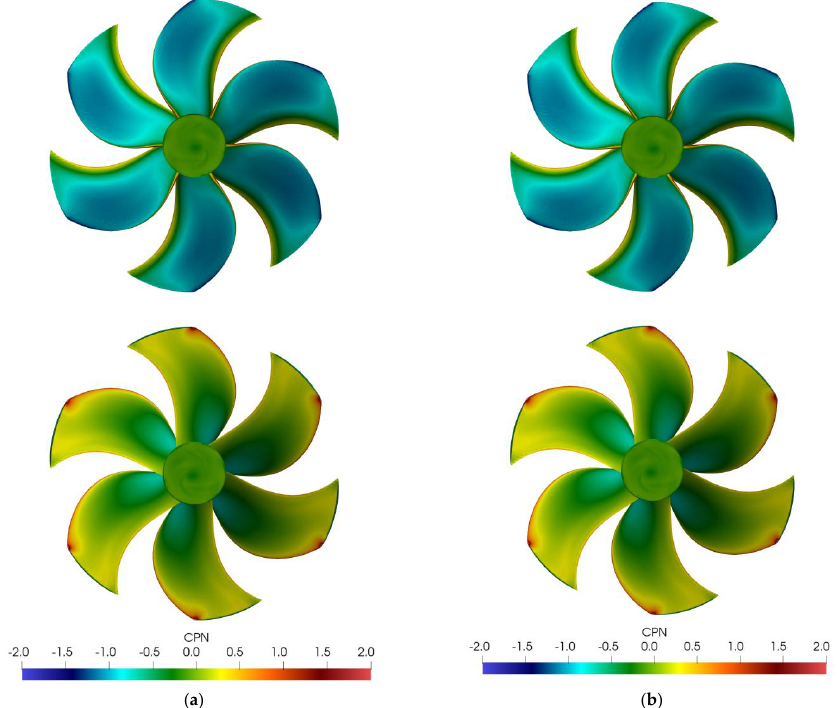
Figure 5. Pressure distributions ( C PN ) on the pressure and suction side of the propellers. Advance coefficient J equal to 0.9 (design point). Instantaneous snapshot after 22 propeller revolutions. ( a ) Conventional CLT; ( b ) New generation